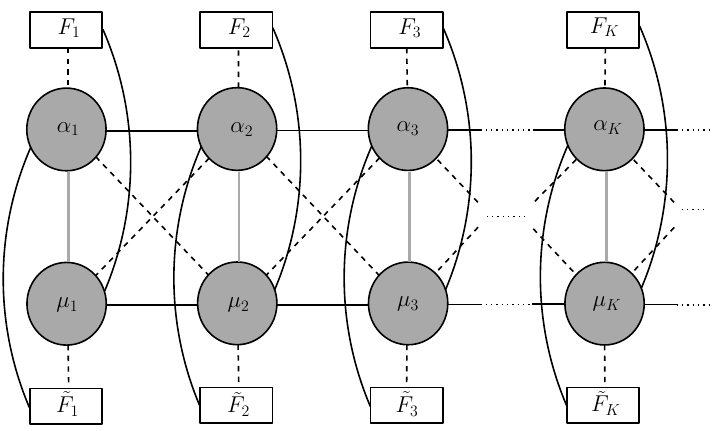
Figure 12 . A generic quiver field theory whose IR is dual to the holographic background defined by the functions in (A.7)–(A.8). The solid black line represents a (4 , 4) hypermultiplet. The grey line represents a (0 , 4) hypermultiplet and the dashed line represents a (0 , 2) Fermi multiplet. N = (4 , 4) vector multiplets are the degrees of freedom in each gauged